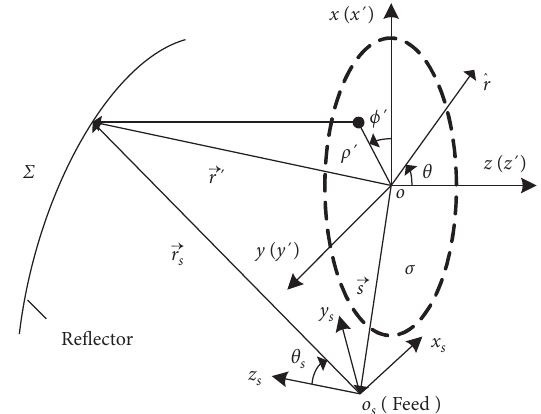
Figure 2: A reflector antenna illuminated by an arbitrarily located